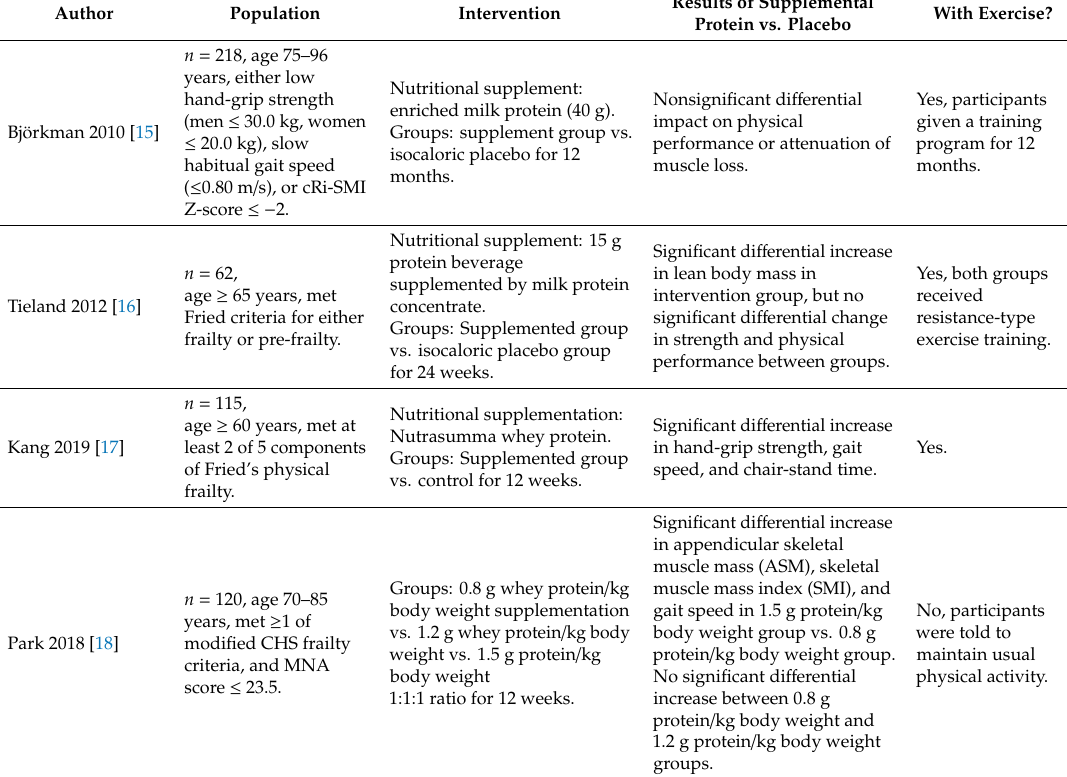
Table 1. Randomized controlled trials of protein supplementation and